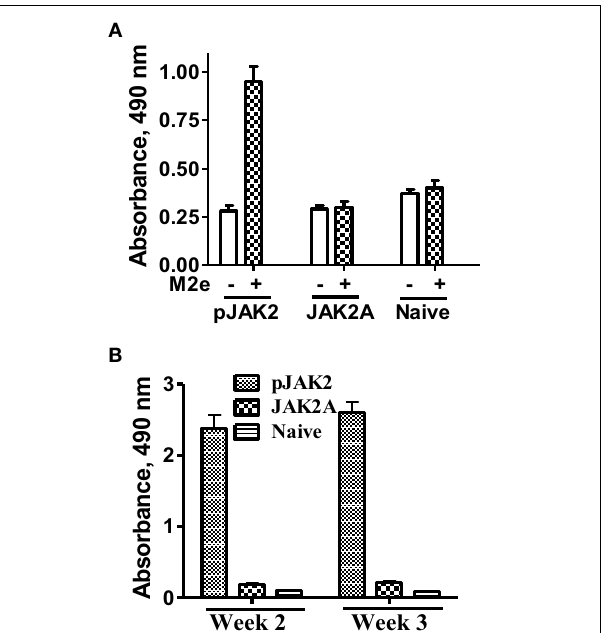
FIGURE 3 | pJAK2(1001–1013) exhibits adjuvant properties at both cellular and humoral levels . (A) Spleens were harvested from C57BL/6 mice ( n = 3) 4weeks after immunization with M2e as an antigen and treatment with pJAK2 or the control peptide. Naïve mice were included as a control. Splenocytes (5 (cid:2) 10 5 cells per well) in microtiter plates were incubated with or without M2e (50 μ g/ml) for 72h. CellTiter Aqueous One Cell Proliferation Assay reagent was added and absorbance was read. p Value of < 0.01 was observed between pJAK2-treated and naïve mice. (B) Mice were immunized using M2e as an antigen in the presence of pJAK2 peptide or the control peptide. After 2 and 3weeks, blood was drawn from the mice and measured for the presence of M2e-specific antibodies in an ELISA format. The values represent average with SD. p Value of < 0.05 was obtained for the SOCS antagonist versus the control